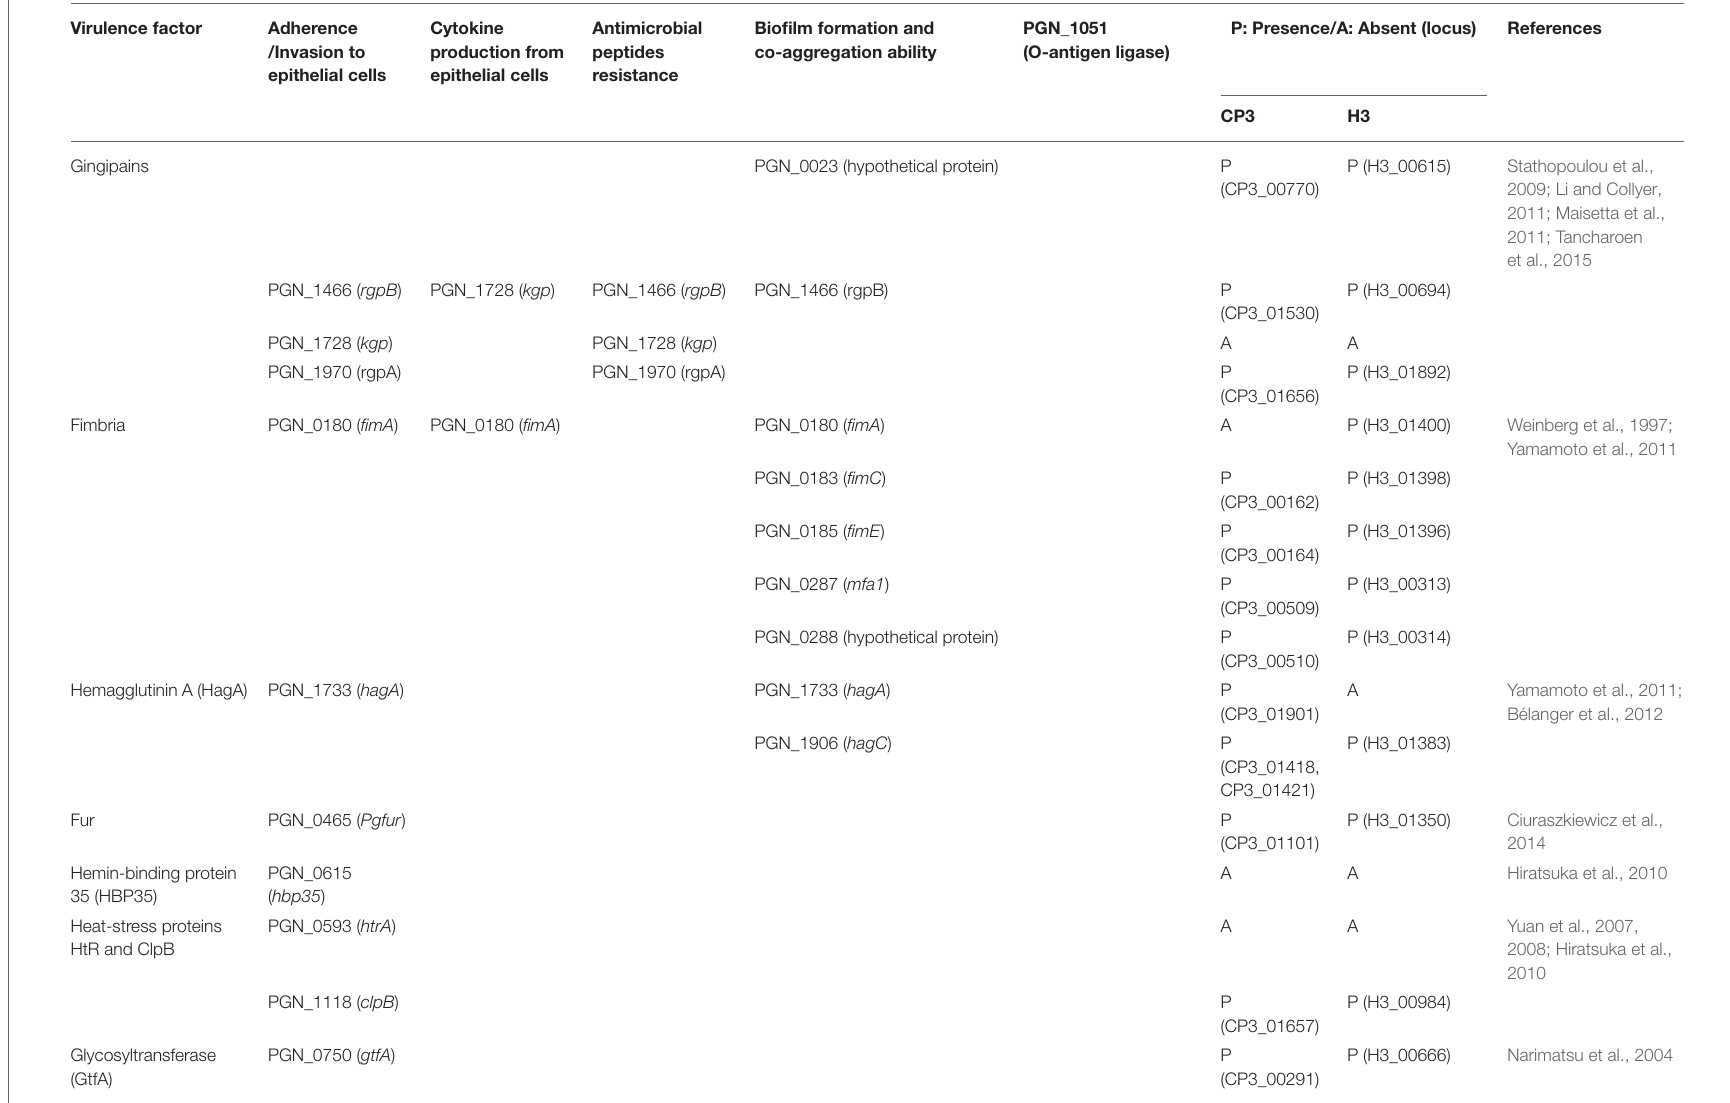
TABLE 2 | Genes involved in Porphyromonas gingivalis virulence. Colonization steps and genes involved in Porphyromonas gingivalis